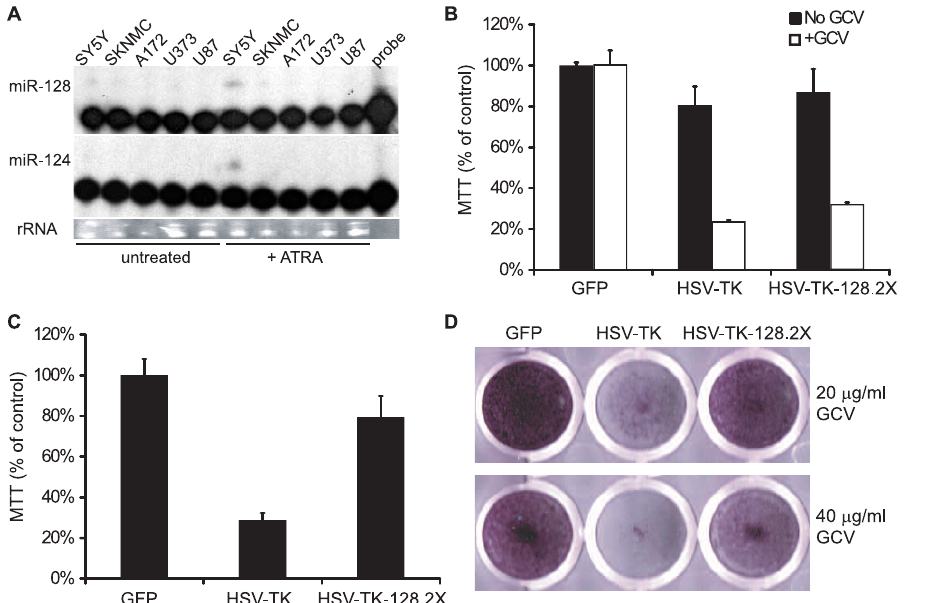
Figure 5. Endogenous miRNA regulation of HSV-TK protects cells from ganciclovir-induced cell death. A. Brain-enriched miRNAs, miR- 128 and miR-124, are induced during neuronal differentiation of SH-SY5Y cells. Cells were grown in the presence of 10 m M ATRA for . 4 days. 10 m g total RNA were used for primer extensions to detect miRNA expression. SH-SY5Y and SKNMC are neuroblastoma cell lines. A172, U373, and U87 are glioblastoma cell lines. B. SH-SY5Y cells were transduced with lentiviral vectors expressing GFP, HSV-TK, or HSV-TK-128.2X, plated in 24-well plates at 1 6 10 4 cells per well, and treated with or without 40 m g/ml GCV for 2 weeks (n=2). C and D. Endogenous miR-128 restricts the activity of HSV-TK- 128.2X. SH-SY5Y cells were transduced as in (B) and plated in 24-well plates at 2.5 6 10 4 cells per well. Cells were cultured in the presence of 10 m M ATRA to induce neuronal differentiation and 40 m g/ml GCV for two weeks (n=2). Cell viability was measured by MTT assay (C), and crystal violet staining of SH-SY5Y cells treated with either 20 m g/ml or 40 m g/ml GCV is shown in